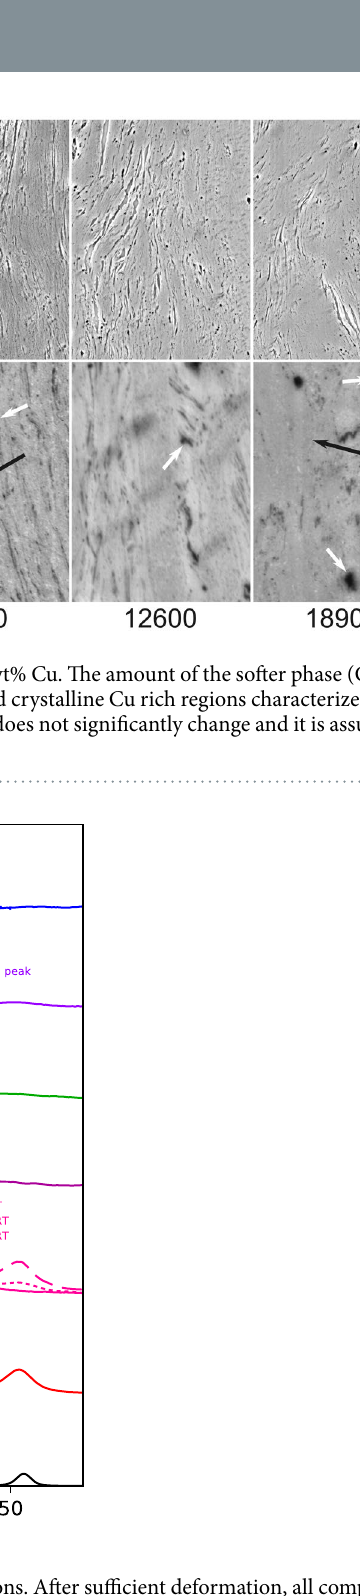
rotations are nearly sufficient to achieve a fully amorphous sample and only a minor peak indicates remaining